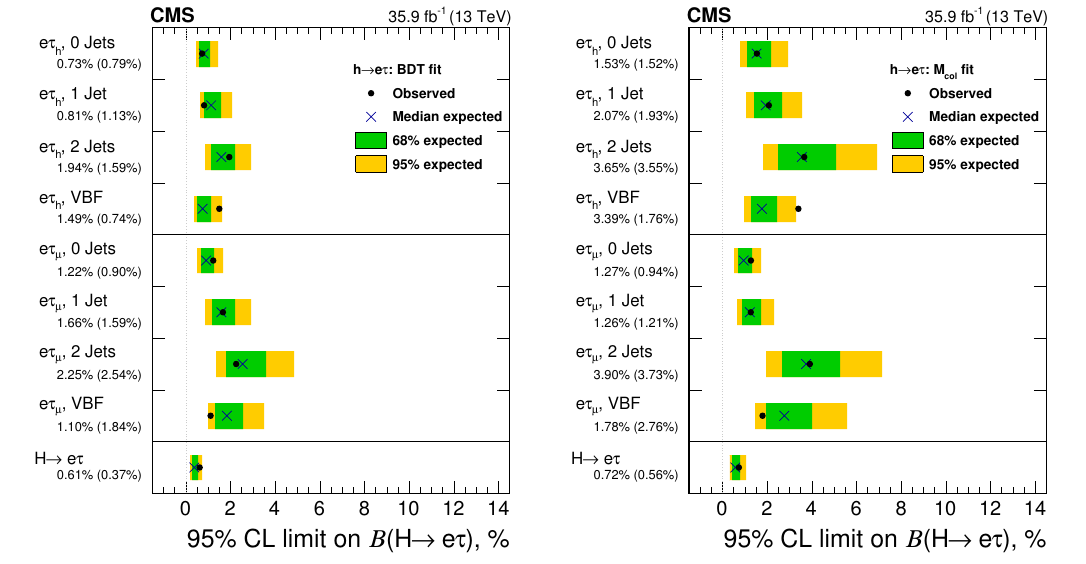
Figure 9 . Observed and expected 95% CL upper limits on the B (H ! e (cid:28) ) for each individual category and combined. Left: BDT (cid:12)t analysis. Right: M col (cid:12)t analysis.